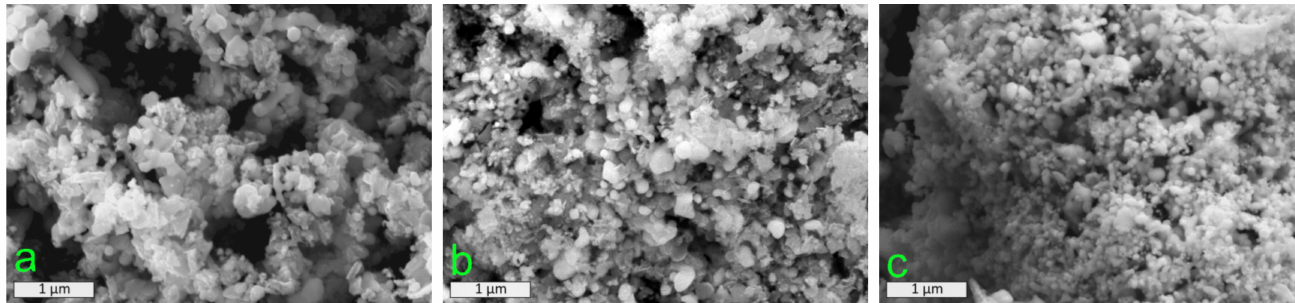
Figure 2. SEM micrographs of the submicrometric powders synthesized by SHS ( × 20,000). ( a ) W-2 wt.% Cr (WCr2), ( b ) W-4 wt.% Cr (WCr4), and ( c ) W-6 wt.% Cr